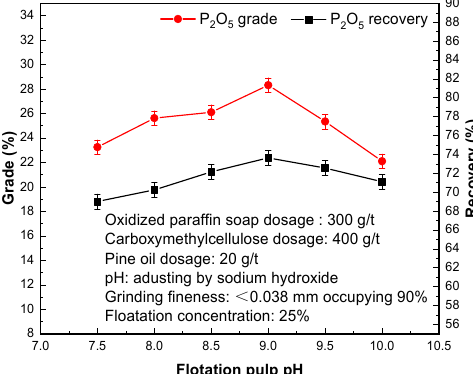
Figure 7. E ff ect of and flotation pulp pH on extracting Figure 7. Effect of and flotation pulp pH on extracting phosphorous.